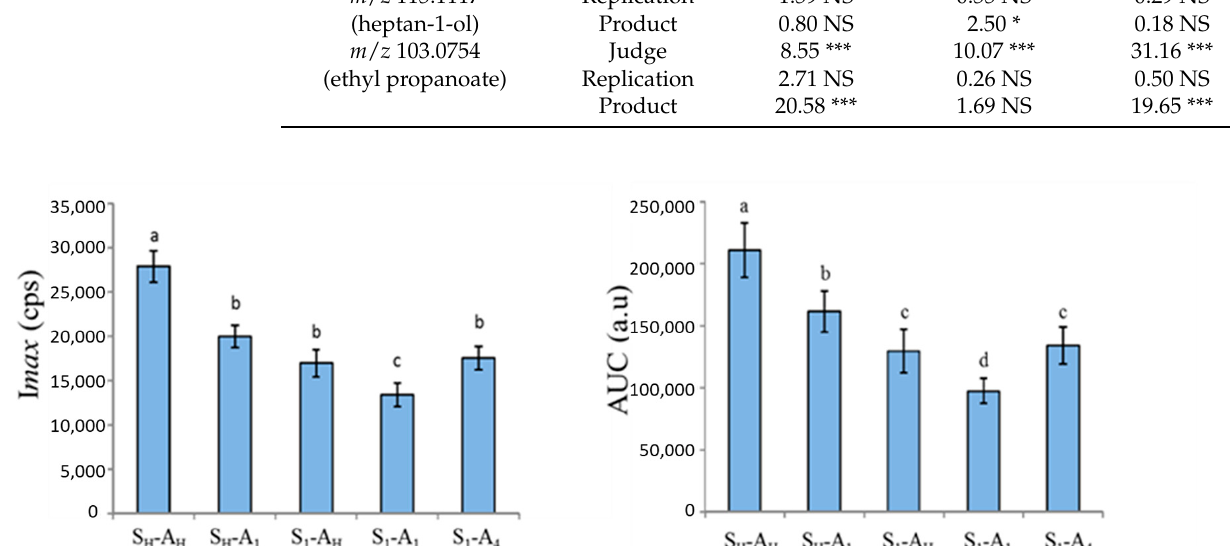
Figure 4. Effect of salt and added aroma distribution on two parameters (I max : maximum intensity and AUC: area under the curve) extracted from PTR-MS (Proton Transfer Reaction Mass Spectrometry) nose space curves for the peak at m / z = 103.0754 (ethyl propanoate). Values represent averages across assessors and replications. Error bars represent standard errors of the means. Identical letters indicate that the mean is not significantly different at a level of 5%. S H and A H : homogeneous distribution of salt and aroma, respectively. S n and A n : heterogeneous distribution of salt and aroma in layer n,